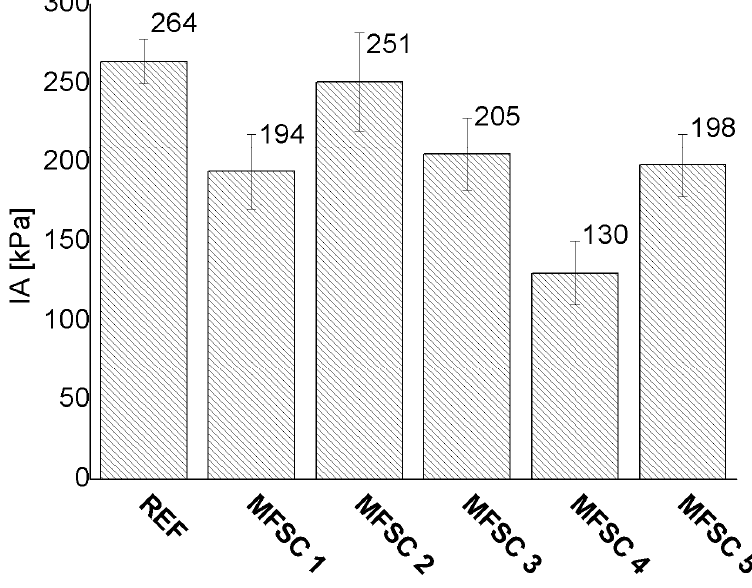
Figure 2. The ice adhesion of gelcoat samples. The reference sample, i.e., an unmodified epoxy gelcoat, achieved the IA value of 264 kPa. All chemical modifications yielded an improvement, namely causing a